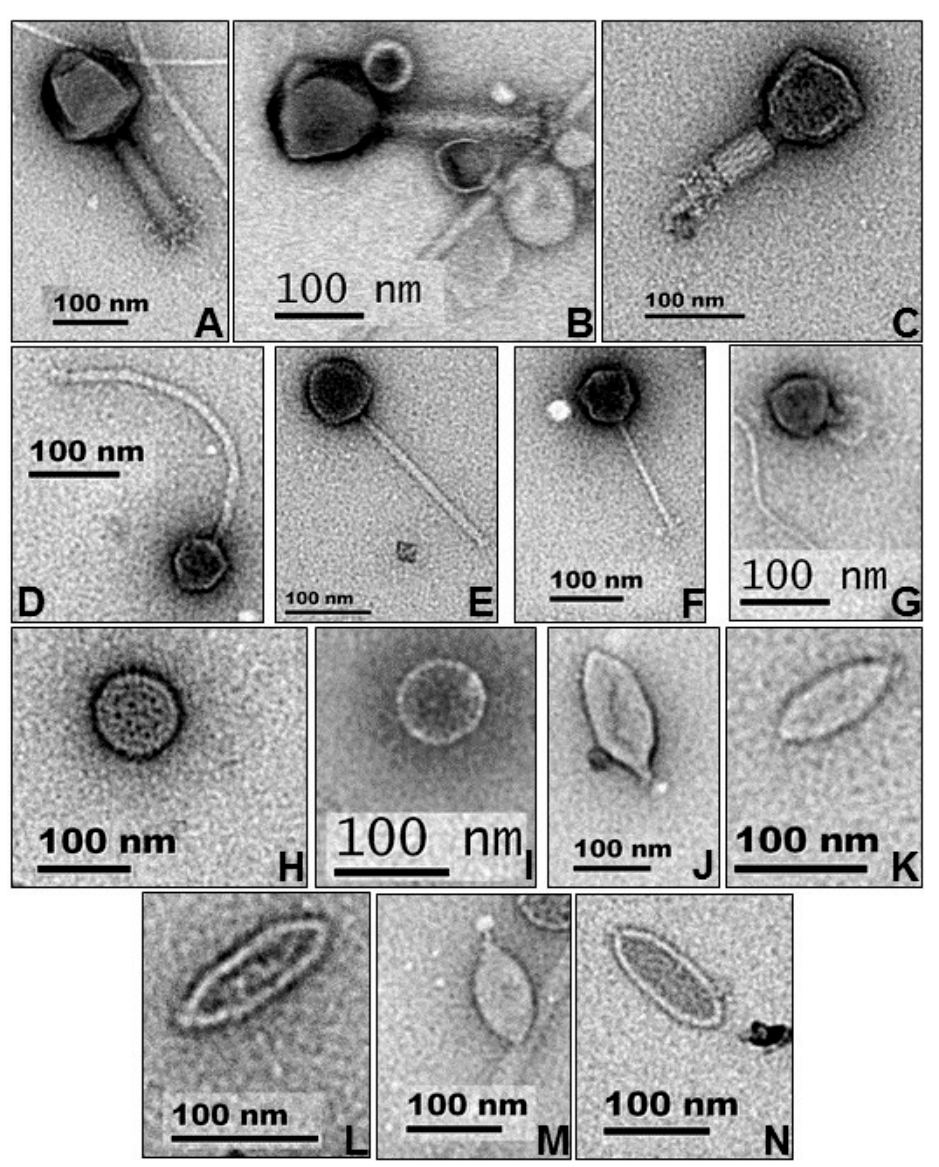
Figure 1. Morphological diversity of observed virus-like particles in Brandvlei hot spring. Each bar represents 100 nm. ( A – C ) Myoviridae ; ( D – F ) Siphoviridae ; ( G ) Podoviridae ; ( H – I ) Unclassified; ( J – N ) Fuselloviridae -like. Table 1. Morphological and quantitative measurements family-level classification of observed virus-like particles (VLPs).